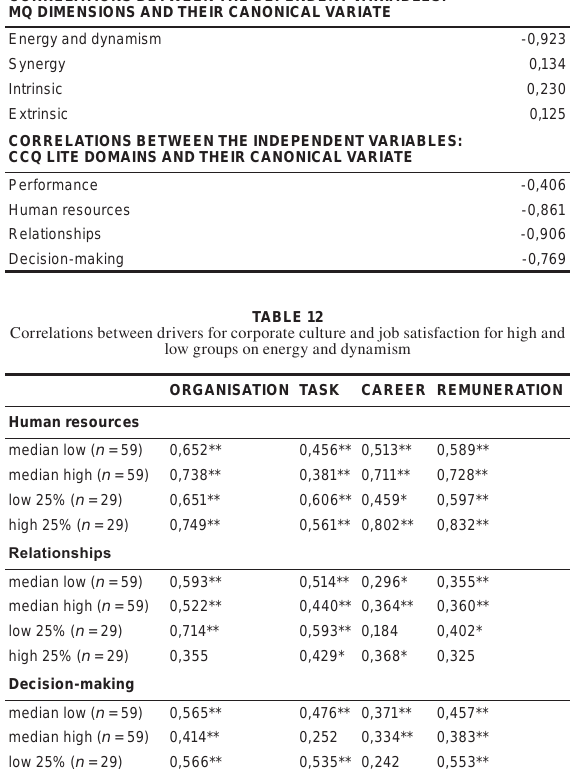
Table 11 Canonical structure for the first canonical function between the CCQ lite domains and the MQ correlaTions beTween THe dePendenT variables: mQ dimensions and THeir canonical variaTe